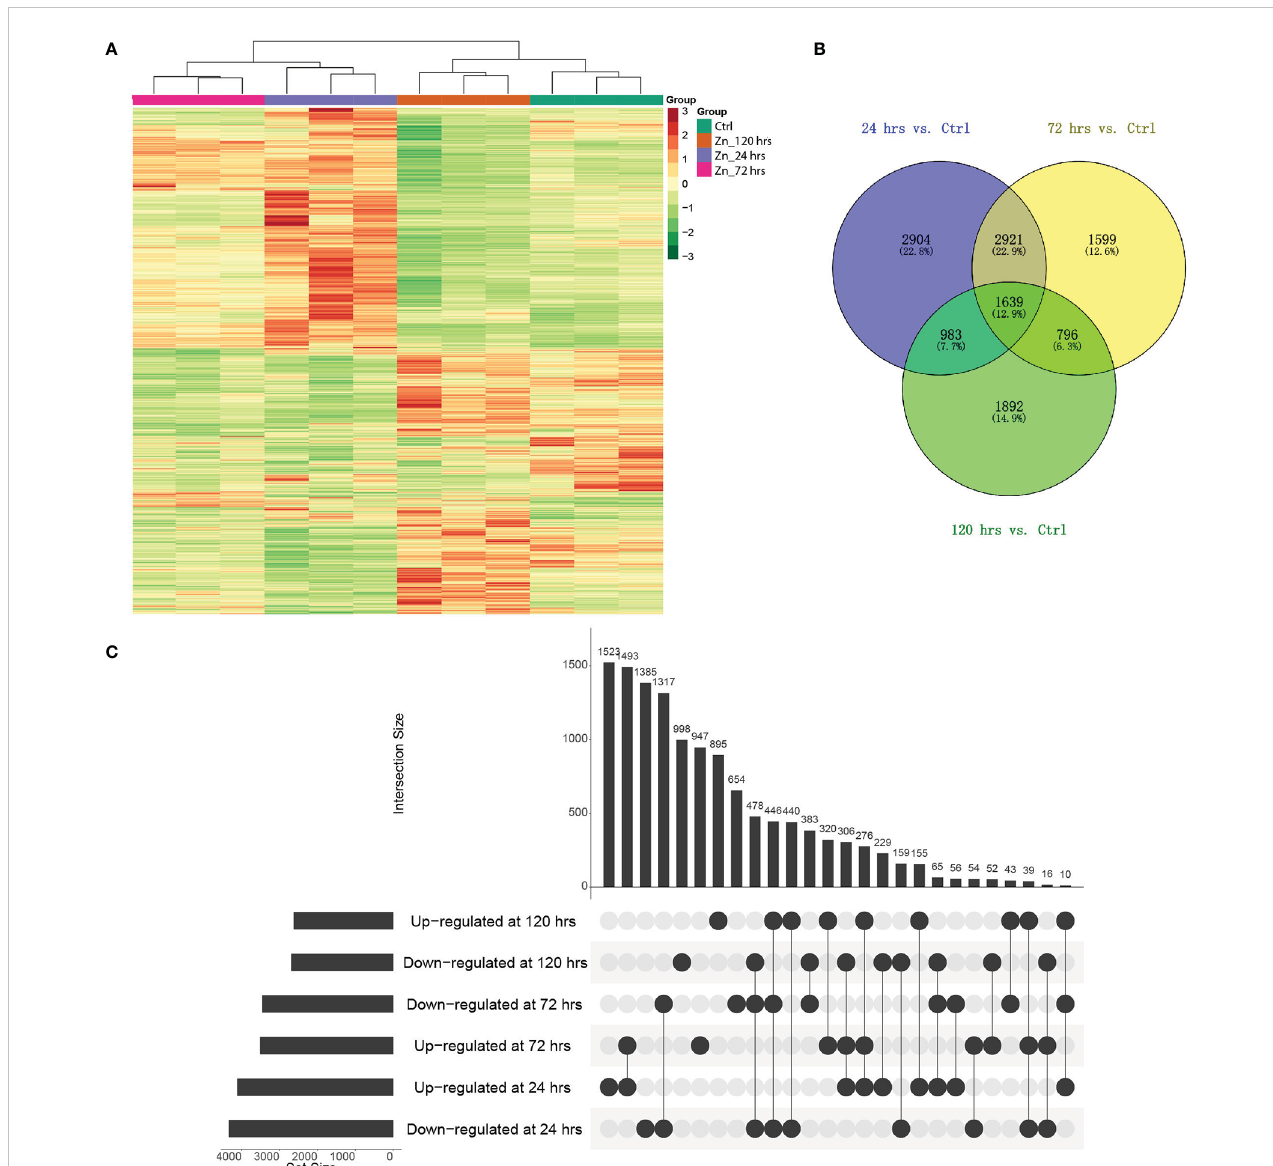
FIGURE 2 Differential gene expression in pumpkin at different time-points after Zn induction. (A) Heatmaps generated with differentially expressed genes after Zn treatments. Column colors indicate treatment type. Red and green colors indicate the relatively higher or lower expression levels of genes, respectively. (B) Venn diagram indicating the overlaps of differentially expressed genes in the pumpkin at three time points (p_value < 0.05). (C) UpSet visualisation of the number of regulated genes at different conditions compared to the control. Filled circles and vertical lines represent the corresponding genes being compared. The left bar graph for the UpSet plot shows the number of signi fi cantly increased or decreased gene changes in each of six comparisons upon Zn